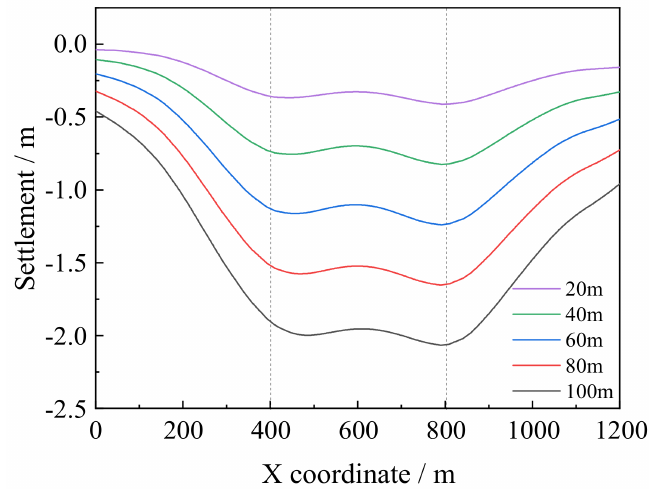
Figure 11. Settlement curves correspond to different reservoir thicknesses.